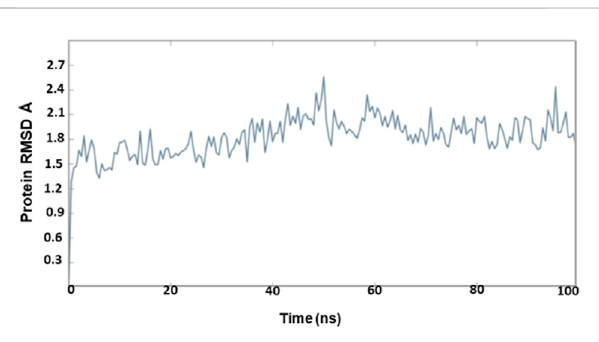
FIGURE 3 RMSD of OXA-27 from 100-ns molecular dynamics The outcome of the simulation reveals that the apo structure was equilibrated in a short time and that some fl uctuations have occurred amid 1.5 and 2.4 Å between 40 and 60 ns. The results evidenced that the system was stable throughout the simulation (Figure 3). To understand further insights from the simulation outcomes related to the speci fi c region of ligand binding, we observed the dynamic behaviour of the loop-containing regions during the simulation run. The residues Lys224 — Ser252 from